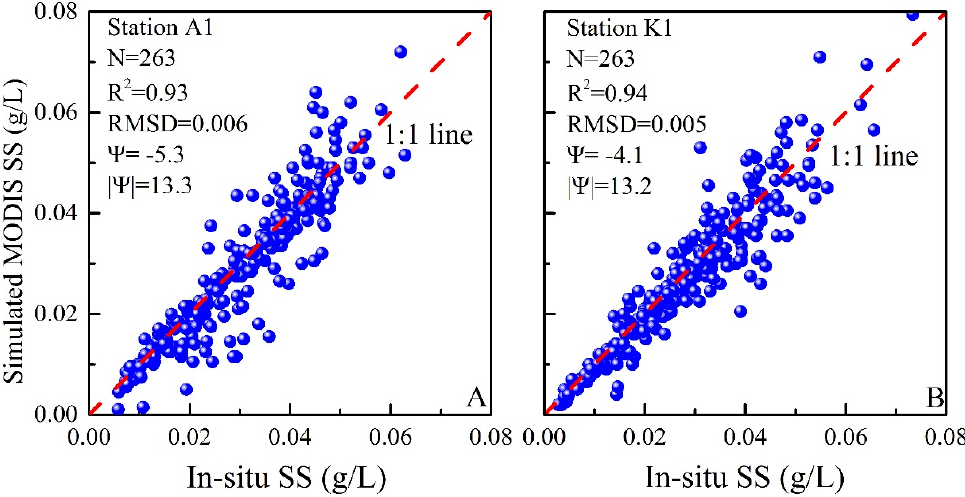
Figure 6. Scatter plots and biases of SS from MODIS (Terra + Aqua) versus in situ SS match-ups at station A1 ( A ) and K1 ( B ).